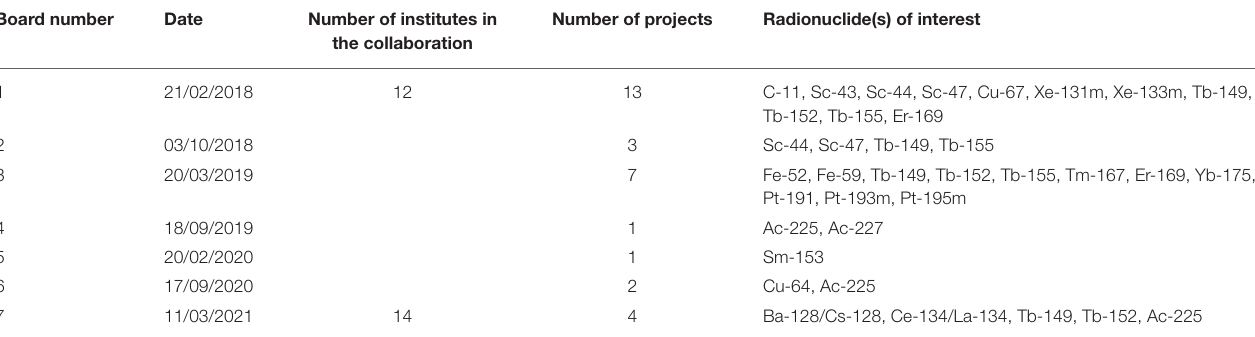
TABLE 1 | MEDICIS collaboration boards, number of institutes taking part in the MEDICIS collaboration, number of submitted projects and list of radionuclides of interest. Board